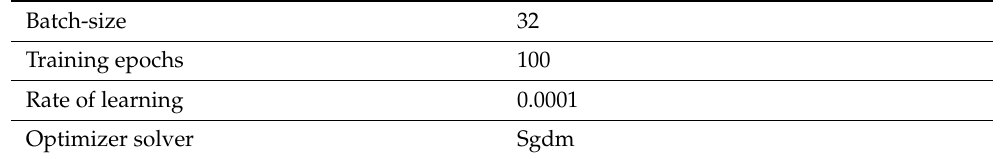
Figure 2. Skin lesions segmentation based on Mobilenet-v2 and Deeplabv3+. The parameters of segmentation are mentioned in Table 1. Table 1. Hyper parameters of the proposed framework. Table 1. Hyper parameters of the proposed framework.